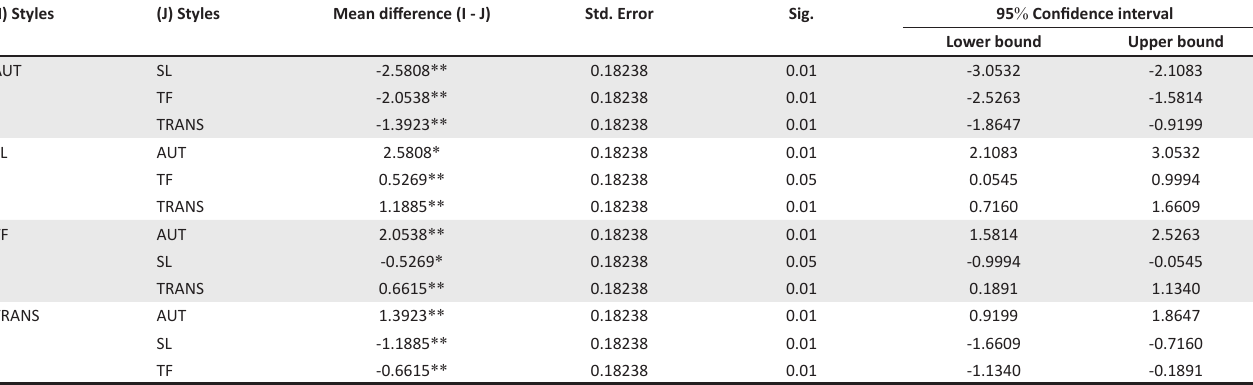
TABLE 2: Tukey’s honest significant difference multiple comparisons (dependent variable = average mean).